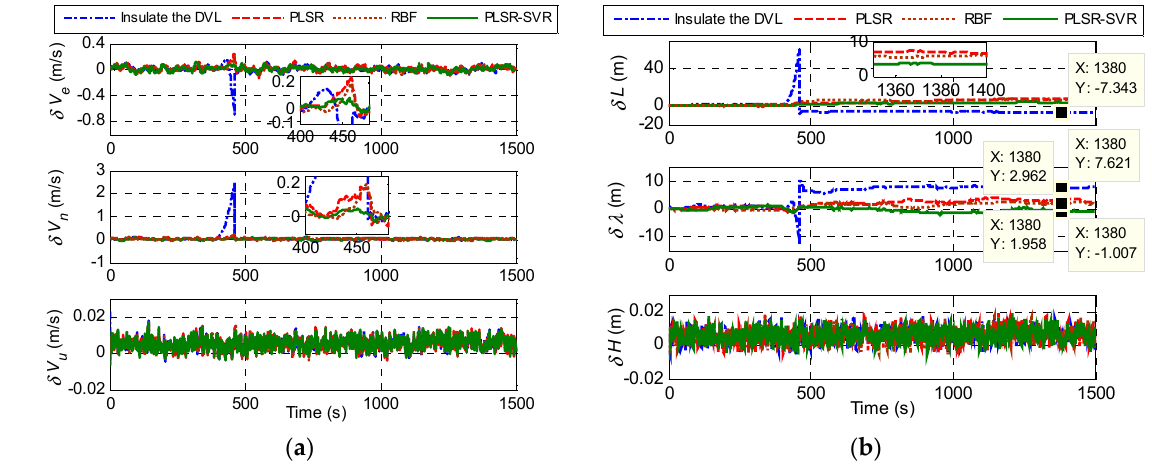
Figure 8. Navigation errors when there is a DVL malfunction for a length of 60 s: ( a ) Velocity errors;